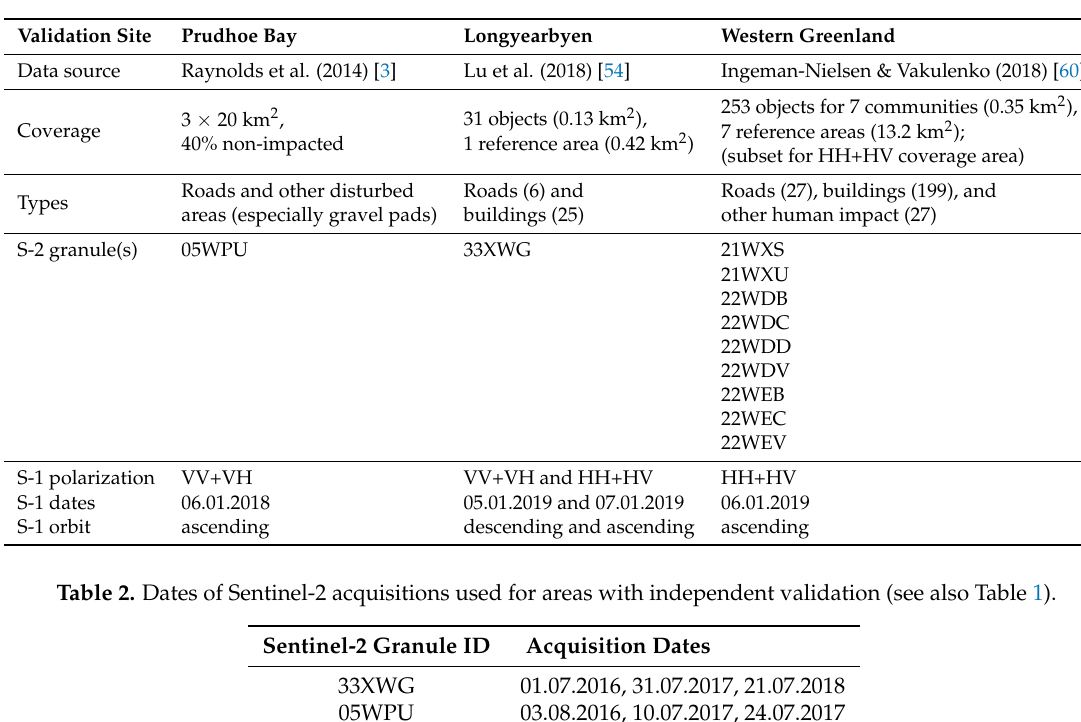
Table 1. Validation data and corresponding Sentinel-1 (S-1) and Sentinel-2 (S-2) acquisitions. Reference objects represent areas without any human impact. Dates for Sentinel-2 are provided in Table 2.